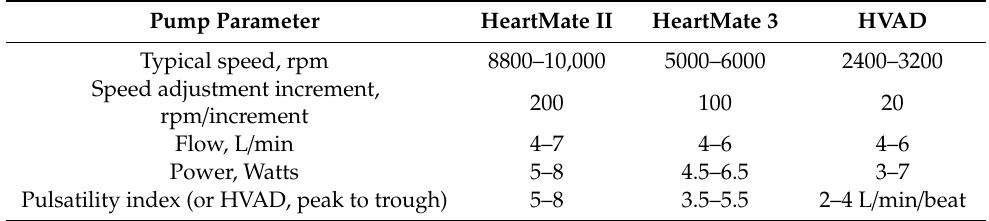
Table 1. Typical LVAD operating parameters.